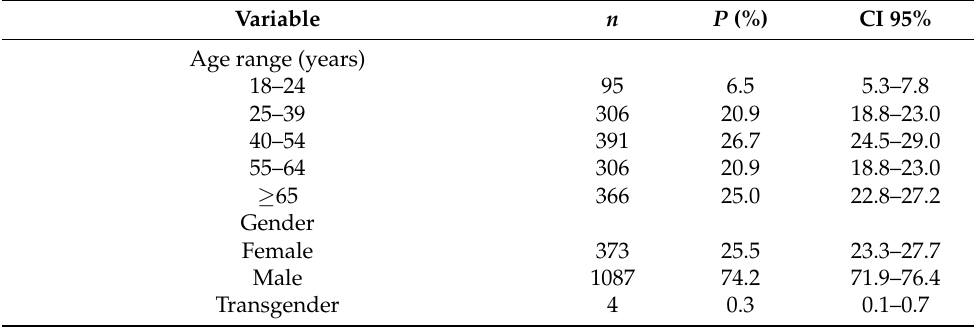
Table 2. Socioeconomic profile of users of popular restaurants ( n = 1464), Salvador/Bahia/Brazil. Variable